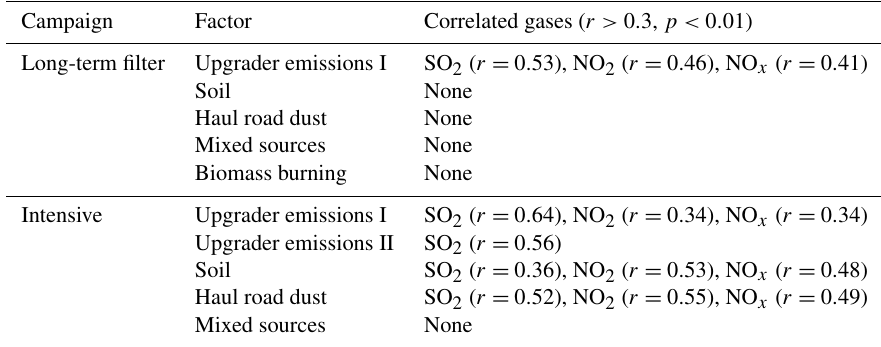
Table 2. Spearman correlation ( r ) of gaseous pollutants with PMF-resolved